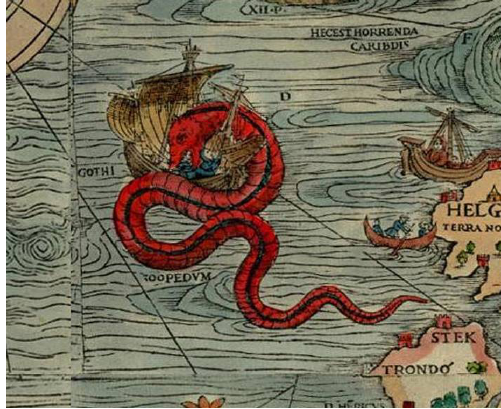
Figure 4. Carta Marina 1539 by Olao Magno (1490–1557),